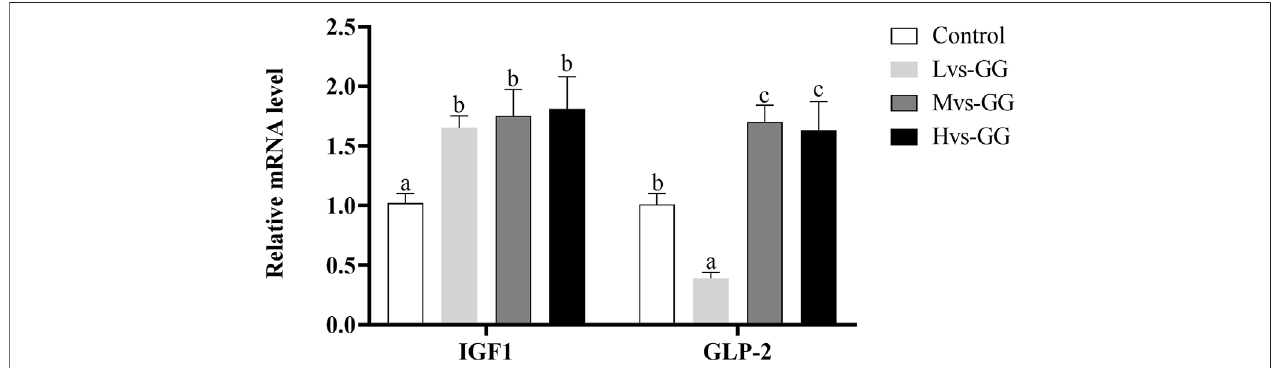
FIGURE 3 | Effects of increasing dietary guar gum viscous on the expression levels of intestinal IGF1 and GLP-2 in juvenile largemouth bass fed different viscous guar gum. Bars represent the mean ± SEM ( n = 4), and different superscript letters represent signi fi cant differences between treatments ( p < 0.05).